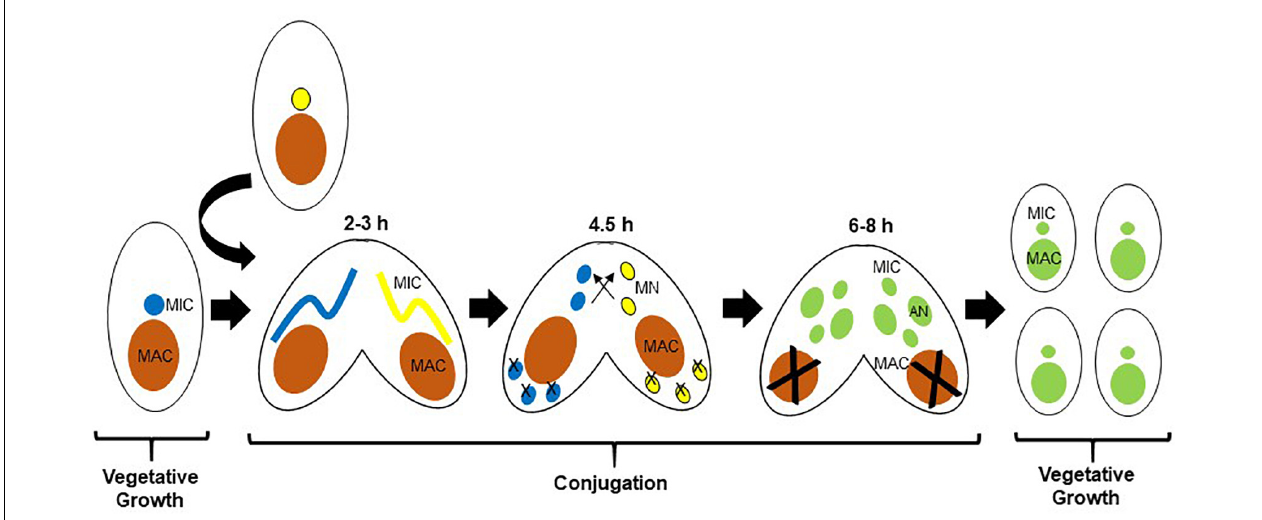
FIGURE 1 | Life cycle of Tetrahymena thermophila (Tt). Parental macronuclei are shown in orange. After pairing of two cells of different mating types, the respective MICs (shown in blue and yellow) undergo meiosis. In each cell, one of the four meiotic products is selected as the nucleus that will be inherited, and the other three degenerate. The selected meiotic product in each cell undergoes mitosis to produce two identical pro-nuclei, one of which is transferred to the mating partner where they fuse to form a zygotic nucleus that further divides mitotically twice to generate four nuclei (shown now in green), two of which will develop as new MACs, and two as MICs. As the new MACs are developing, the parental MAC condenses and degenerates. Time periods shown correspond to hours post mixing of the two